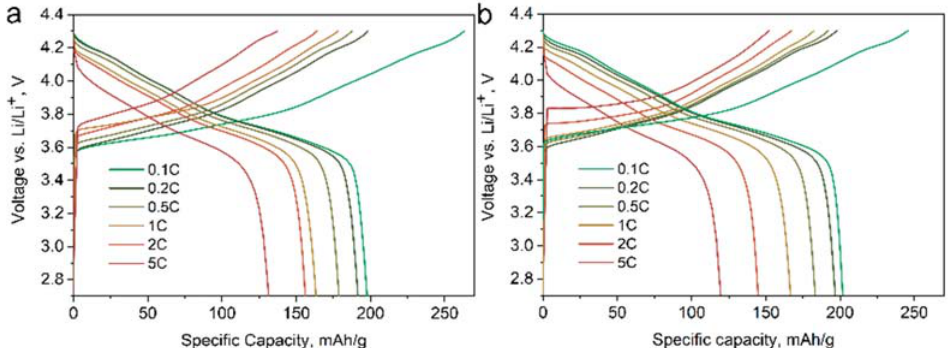
Figure 12. Galvanostatic charge-discharge curves at different current densities for the NMC811 samples CP_A ( a ) and CP7_MW3 ( b ) in half cells with metallic lithium anode.